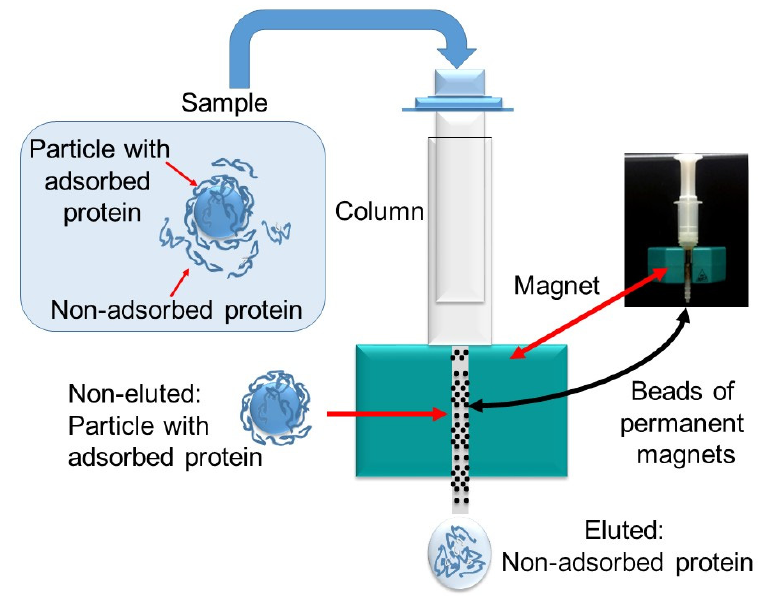
Figure 6. Experimental setup for determination of proteins bound to magnetic nanoemulsions. The MACS columns are composed of a spherical steel matrix; by inserting a column in a MACS separator, a high ‐ gradient magnetic field is induced within the column, which retains the magnetic particles. A polyacrylamide gel electrophoresis ‐ sodium dodecyl sulfate (PAGE ‐ SDS) electrophoresis was performed with the protein ‐ associated magnetic droplets. After dying with Blue ‐ Coomassie, two main bands appeared, approximately at the same level for both nanoemulsions. The upper band is located at the same level as the band of the marker corresponding to 220,000 Da, whereas the lower band is between the bands of the marker corresponding to 60,000 Da and 45,000 Da, but closer to 60,000 Da (Figure 7). From the figure, it is clear than the LE nanoemulsion droplets have adsorbed more protein than HE droplets do.